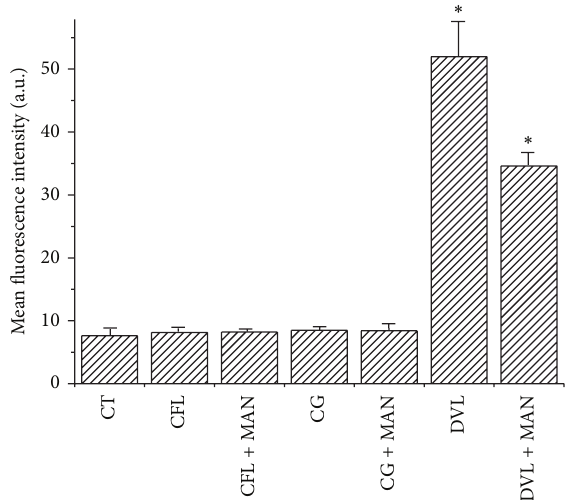
Figure 5: Fluorescence intensity of blocked and unblocked FITC- lectins. The data are expressed as means ± error. ∗ 𝑃 < 0.05 related to the control and # 𝑃 < 0.05 related to